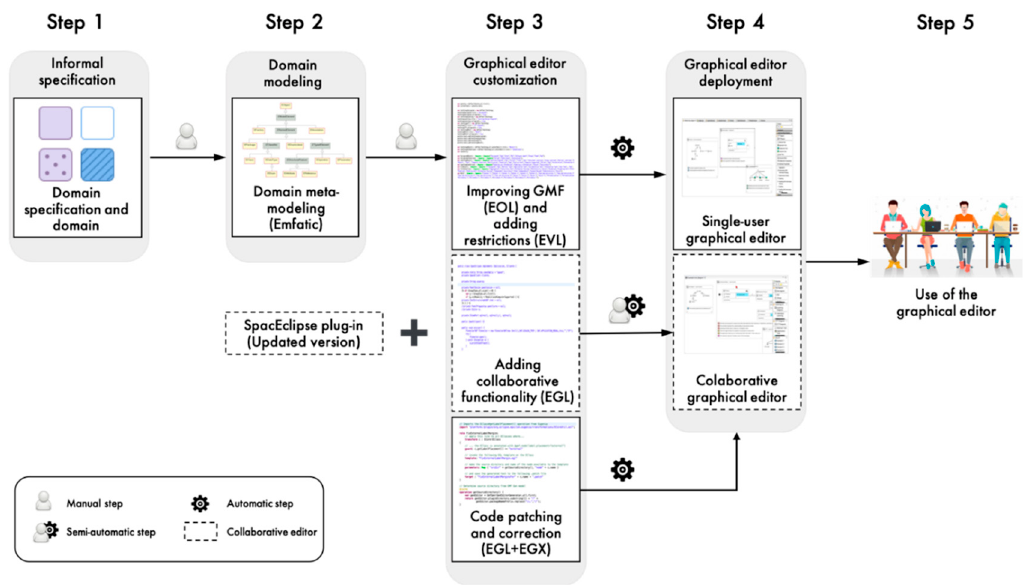
Figure 3. Outline of the model-driven development